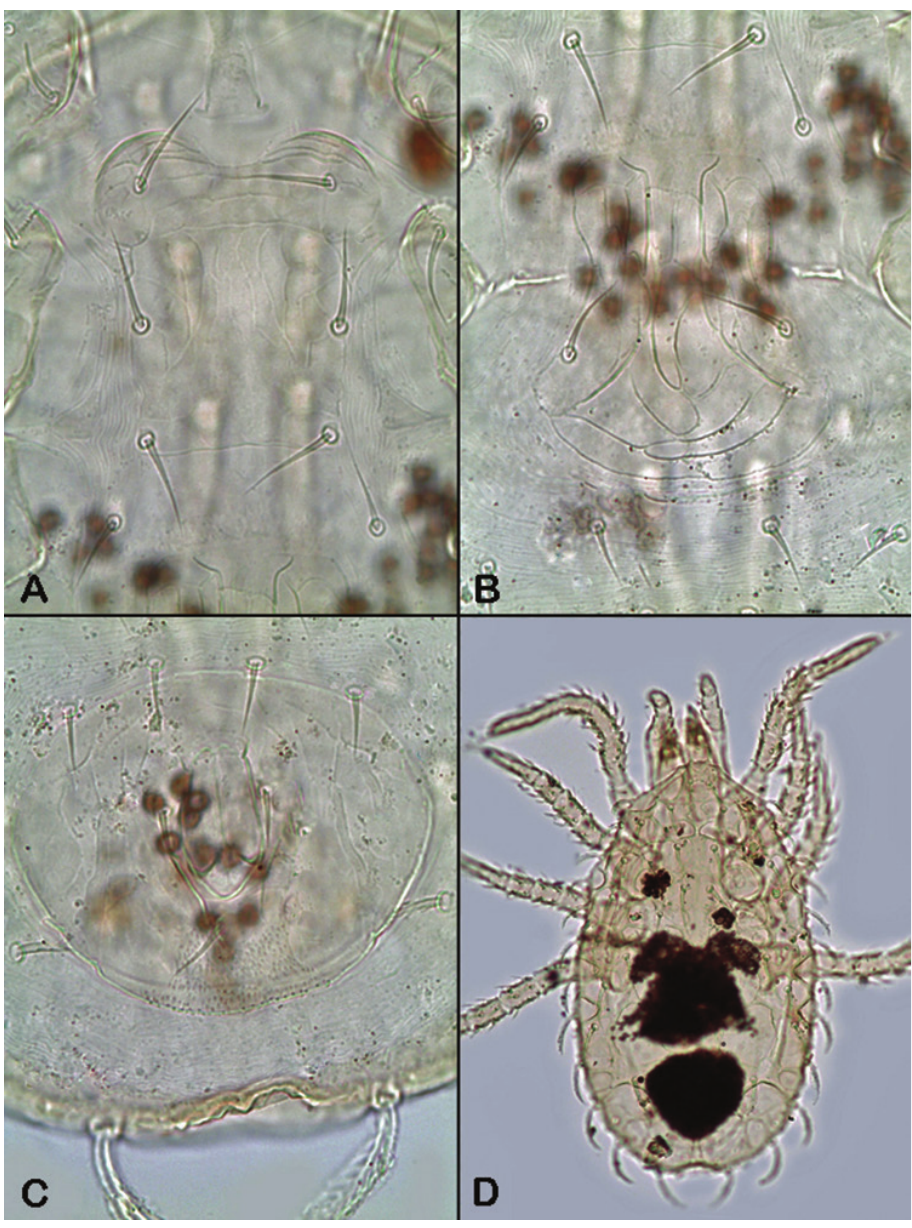
Plate 75. Sinoseius lobatus , female. A Sternal shield B Epigynal shield C Anal shield D Dorsal idiosoma with